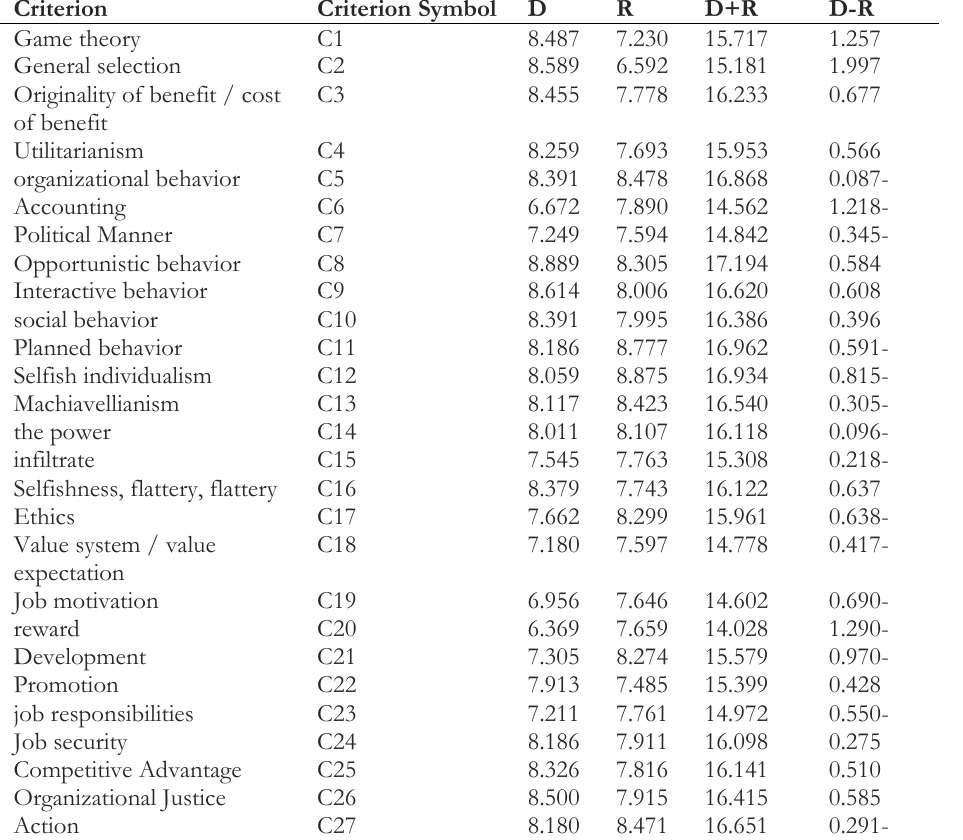
Table 5. Pattern of causal relationships of the main criteria.